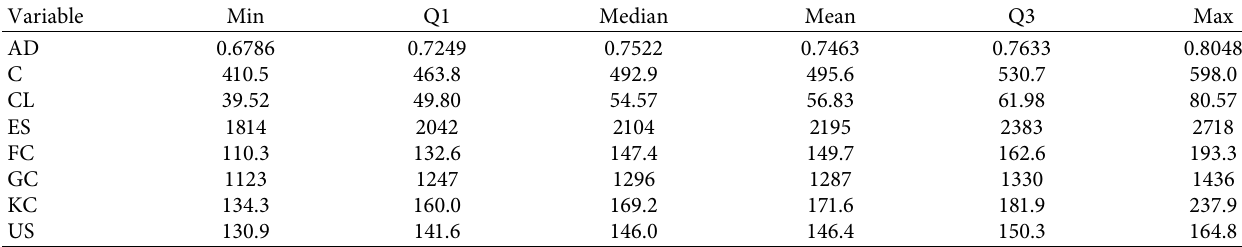
Table 2: Descriptive statistics of major financial instruments.